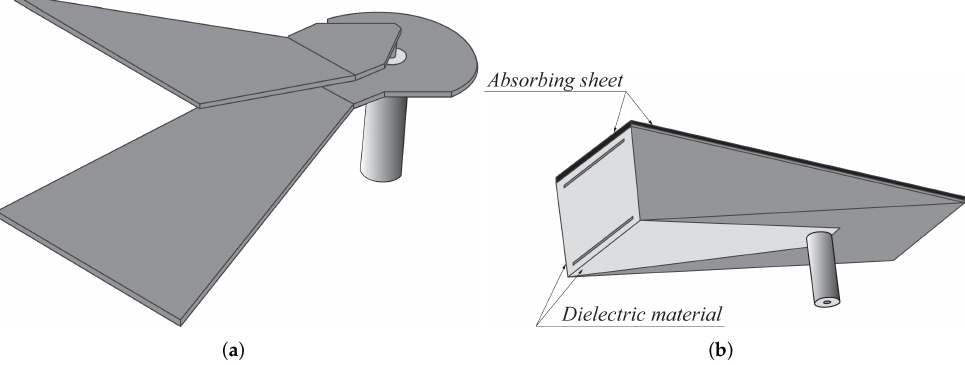
Figure 32. ( a ) 3D view of flared TEM horn antenna ( b ) The horn enclosed in a dielectric medium (redrawn from [125,126]). Dark gray metal face and light gray dielectric